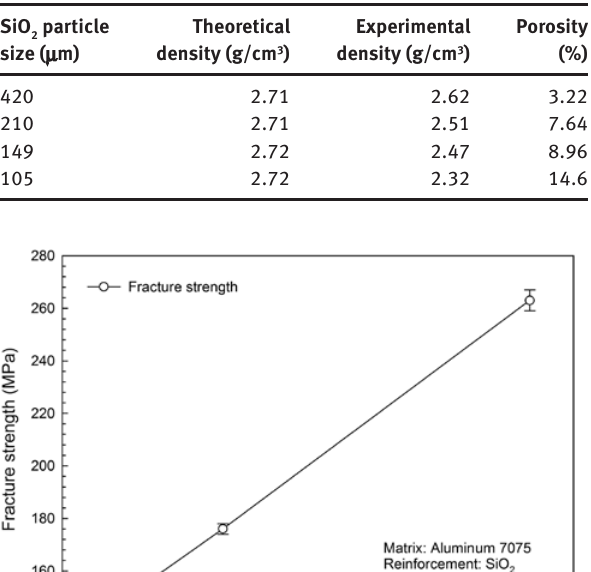
Table 4: Density and porosity values with reinforcement particle size.